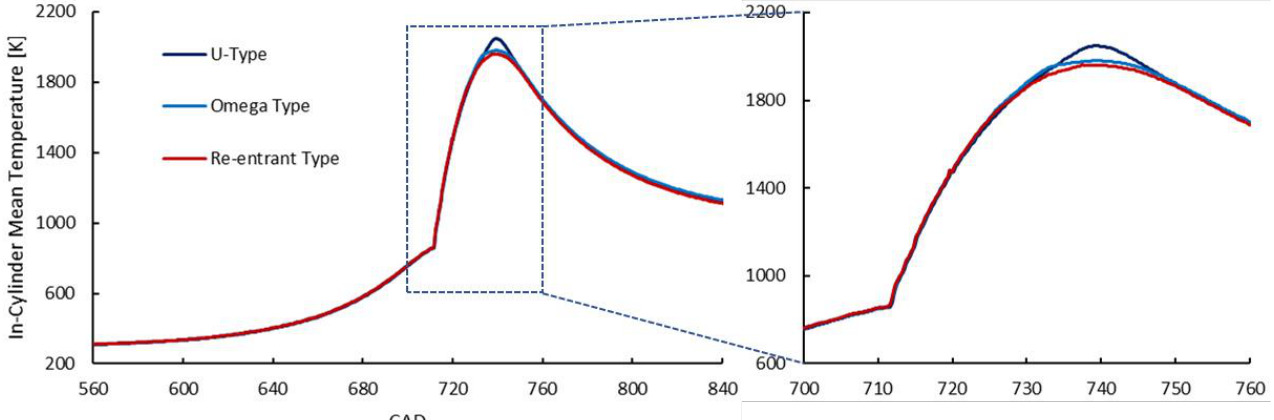
Figure 8. In-cylinder mean temperature diagrams.